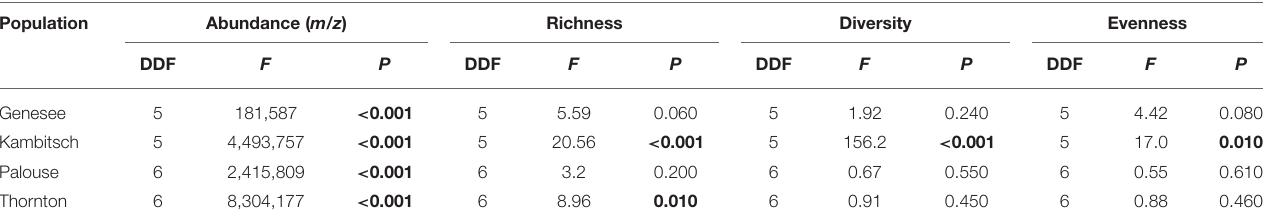
TABLE 4 | Results from ANOVA for floral scent VOC abundance ( m/z ), richness, diversity, and evenness among half-sibs of three families across four Anthemis cotula populations a . Population Abundance ( m/z ) Richness Diversity Evenness